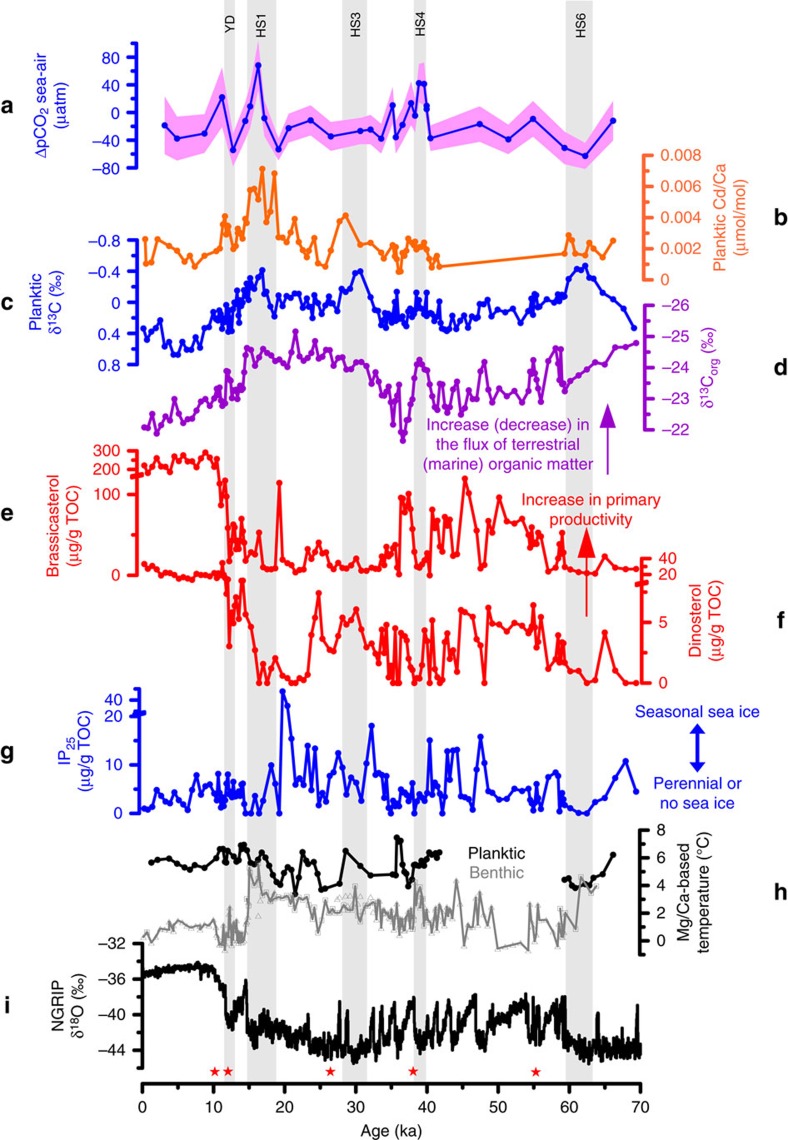
Proxy records of sediment core JM-FI-19PC plotted with North Greenland Ice Core Project δ18O values.(a) ΔpCO2sea-air. (b) Cd/Ca measured in N. pachyderma. (c) δ13C measured in N. pachyderma. (d) δ13C measured in organic matter (δ13Corg) (ref. 16). (e) concentration of brassicasterol16. (f) concentration of dinosterol16. (g) C25 isoprenoid lipid (IP25) (ref. 16). High concentration of IP25 suggests presence of seasonal sea ice, whereas absence of IP25 suggests either permanent sea-ice cover (when the concentration of sterols is low) or open ocean conditions (when the concentration of sterols is high) (see Hoff et al.16 for details). Note the break in the y-axes of plots e–g. (h) shallow subsurface (black) and bottom water (grey) temperature1415. Bottom water temperatures are based on Mg/Ca in the benthic foraminiferal species Melonis barleeanus (triangles) and Cassidulina neoteretis (squares). Shallow subsurface temperatures are based on Mg/Ca in N. pachyderma. (i) North Greenland Ice Core Project (NGRIP) ice core δ18O values2867. Red stars on the x-axis indicate tephra layers that are common to sediment core JM11-FI-19PC and Greenland ice cores (Supplementary Fig. 1).